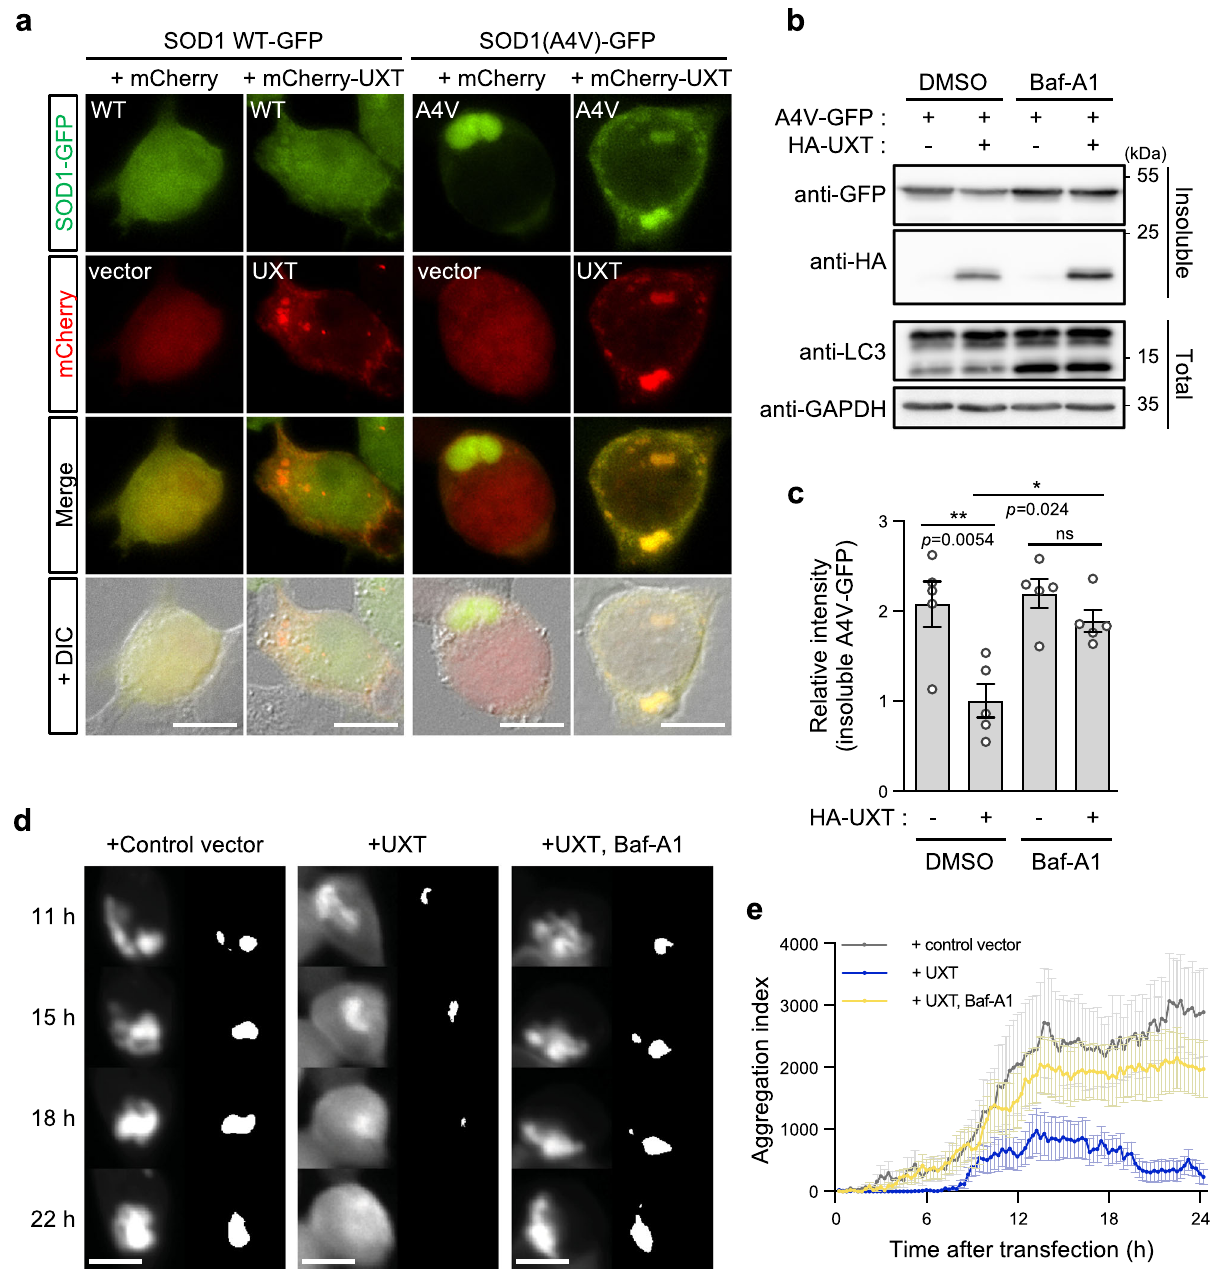
Fig. 4 UXT mediates the clearance of SOD1(A4V) aggregates by autophagy. a HEK293T cells were transiently transfected with SOD1 (wild type or A4V)-GFP and mCherry-UXT or mCherry-only control. Representative images of transfected cells, merged composites and differential interference contrast (DIC) images are shown. Scale bar, 10 μ m. b HEK293T cells were transiently transfected with SOD1(A4V)-GFP and HA-UXT or vector, and were treated with 50 nM ba fi lomycin A1 (Baf-A1) for 12 h, as shown. SOD1 and UXT were detected by western blotting in the detergent-insoluble fraction. LC3 in whole-cell lysates were analyzed to con fi rm inhibition of autophagic fl ux by Baf-A1, and GAPDH was used as an internal loading control. c Band intensities of SOD1(A4V)-GFP in detergent-insoluble fractions were normalized against those of HA-UXT-transfected cells without Baf-A1 treatment, and are shown as bar graphs ( n = 5, mean ± SEM). * p < 0.05; ** p < 0.01; ns not signi fi cant (one-way ANOVA using Bonferroni ’ s multiple comparison test). d Immediately after HEK293T cells were transiently co-transfected with SOD1(A4V)-GFP and mCherry-UXT or mCherry-only control, the cells were either treated with 50 nM ba fi lomycin or DMSO as a control, and fl uorescence images of SOD1(A4V)-GFP in mCherry-positive cells were captured at 15 min intervals for 24 h. Representative images at 11, 15, 18, and 22 h are shown. Black and white images indicating pixels automatically recognized as aggregate regions by an in-house MATLAB code (Supplementary Code 1) are also shown. Scale bar, 10 µ m. e Averages of the aggregation indexes of cells in d that were vector control transfected (gray, n = 10), mCherry-UXT transfected (blue, n = 11), and mCherry-UXT transfected along with ba fi lomycin A1 (Baf-A1) treatment (yellow, n = 17) are shown. Mean ± SEM is indicated.